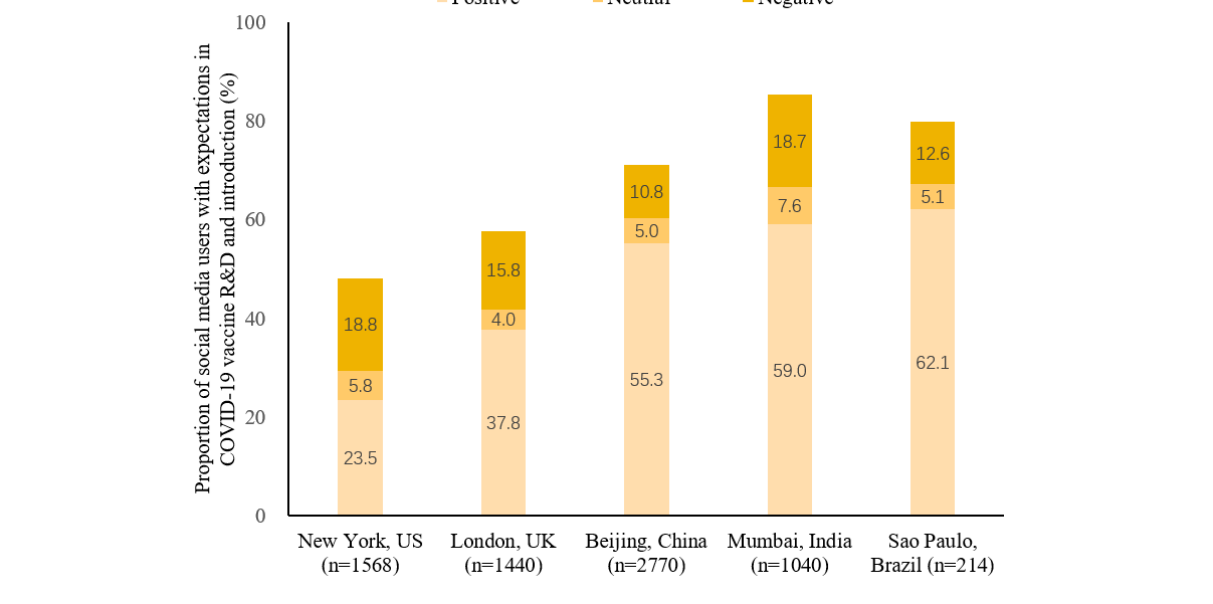
HIC users expressed distrust in governments (>10%) and experts (around 5%). Furthermore, 11.8% (185/1568) and 11% (158/1440) of users in New York and London, respectively, mentioned misinformation, rumors, or antivaccine campaigns, but few users in LMIC metropolises (<7%) shared these